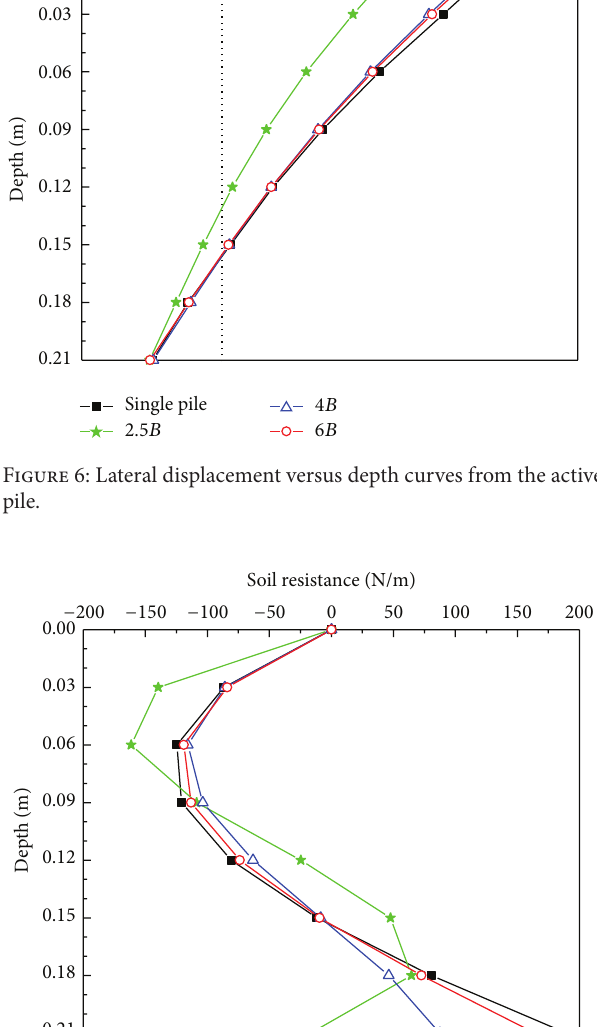
Figure 5: Moment versus depth curves from the active pile.